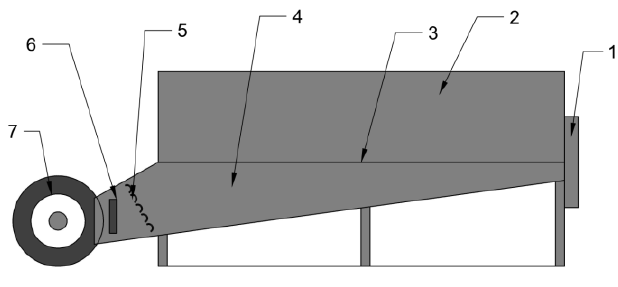
Figure 1: Description of the fluidized bed dryer